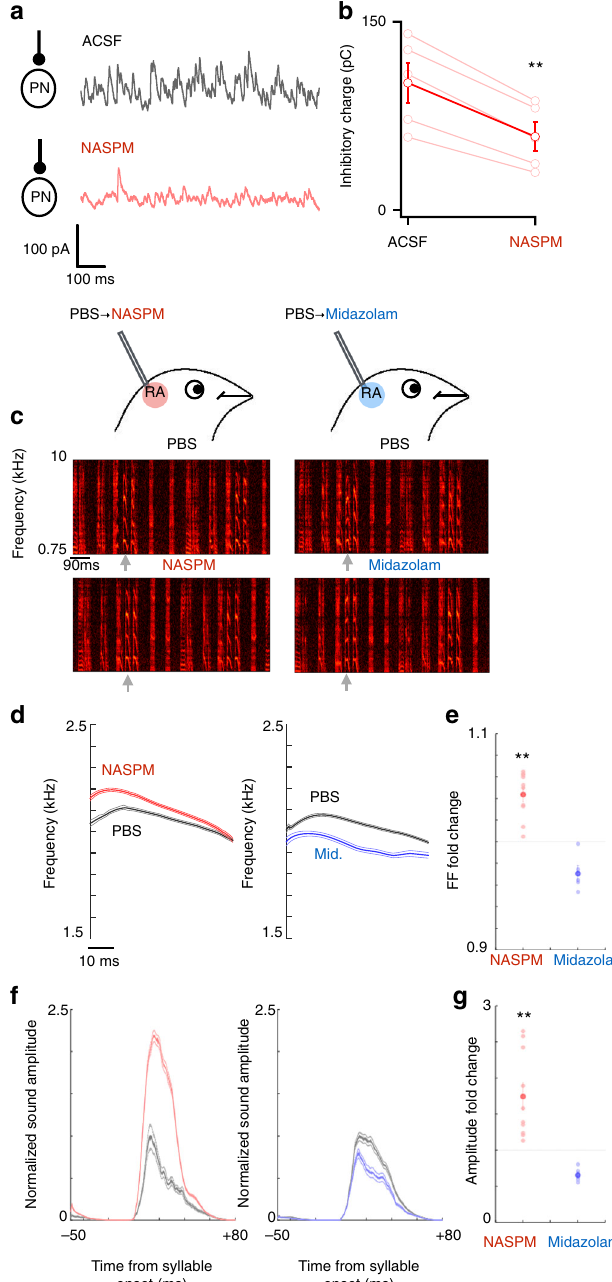
Fig. 5d, e) and syllable amplitude ( − 34.4 ± 4.5%, n = 5, p = 0.004 Fig. 5f, g). Like NASPM, however, midazolam dialysis speci fi cally altered FF and amplitude without altering syllable structure